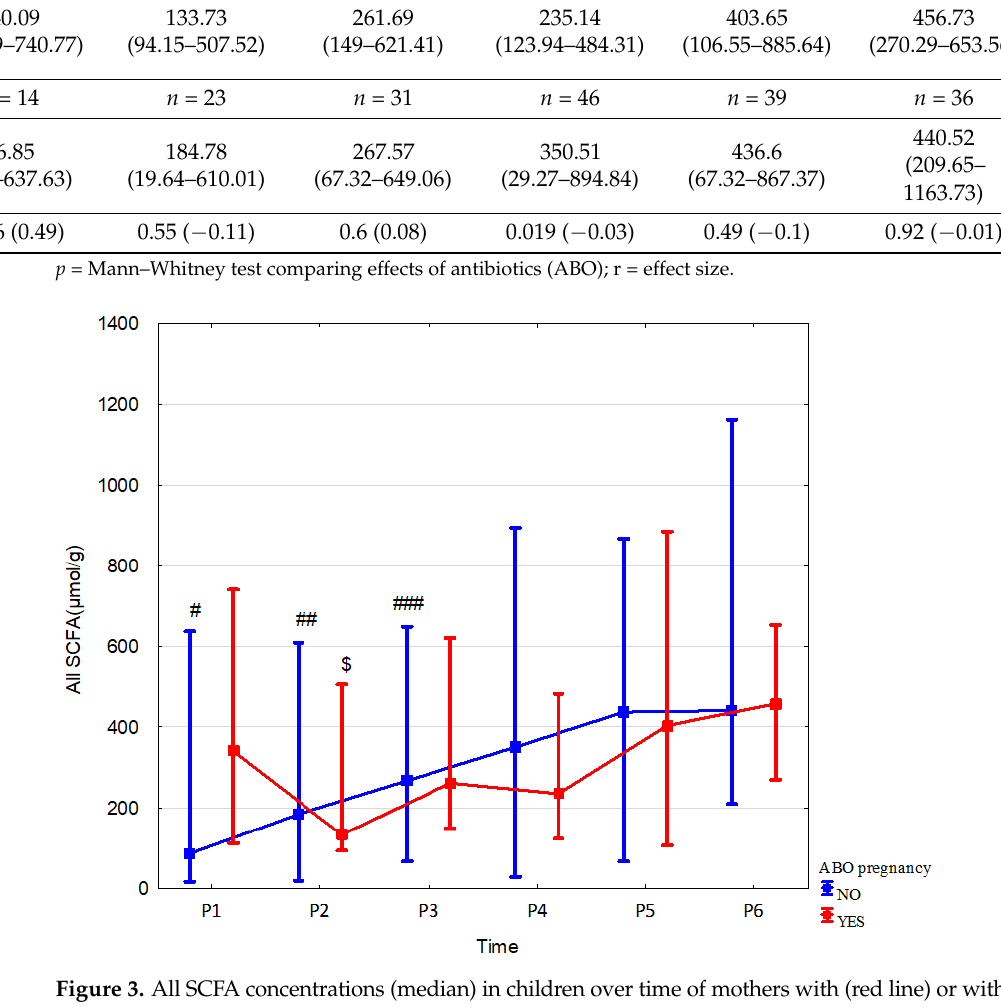
Table 4. Effects of antibiotic therapy during pregnancy on all SCFA concentrations .